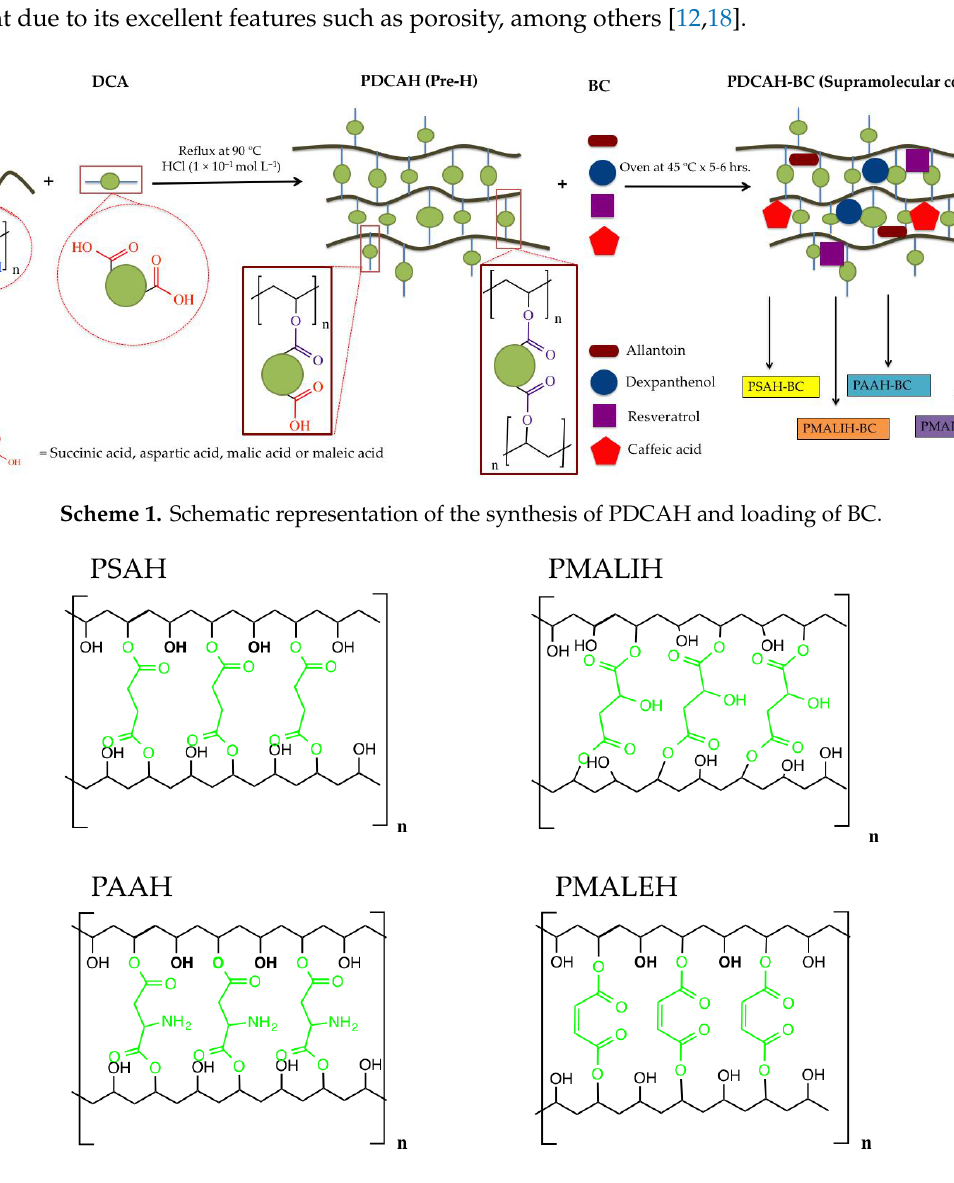
Figure 1. Proposed structures of PDCAH.